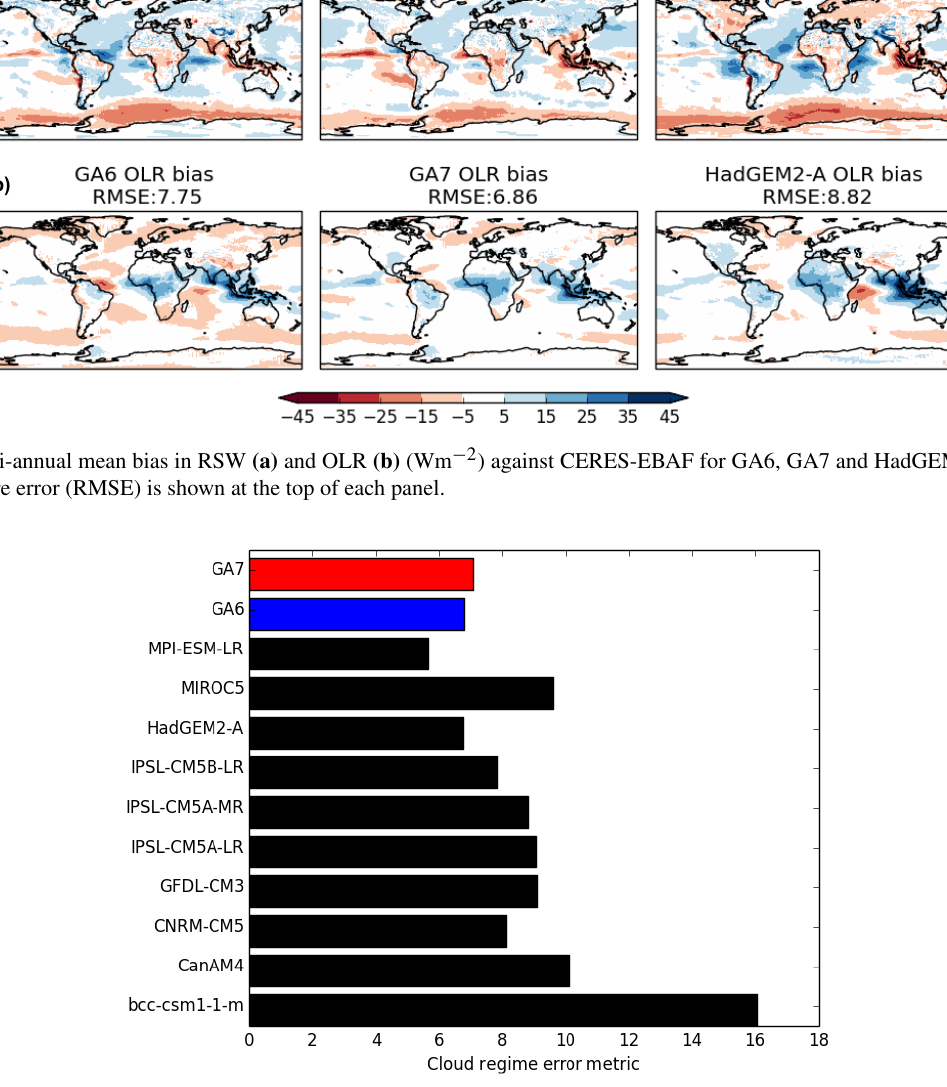
Figure 14. Cloud regime error metric (CREMpd) from Williams and Webb (2009) for the global cloud regimes of Tselioudis et al. (2013), calculated for GA6 (blue), GA7 (red) and all of the CMIP5 models which have the required diagnostics available (black). Zero represents a perfect score with respect to the ISCCP